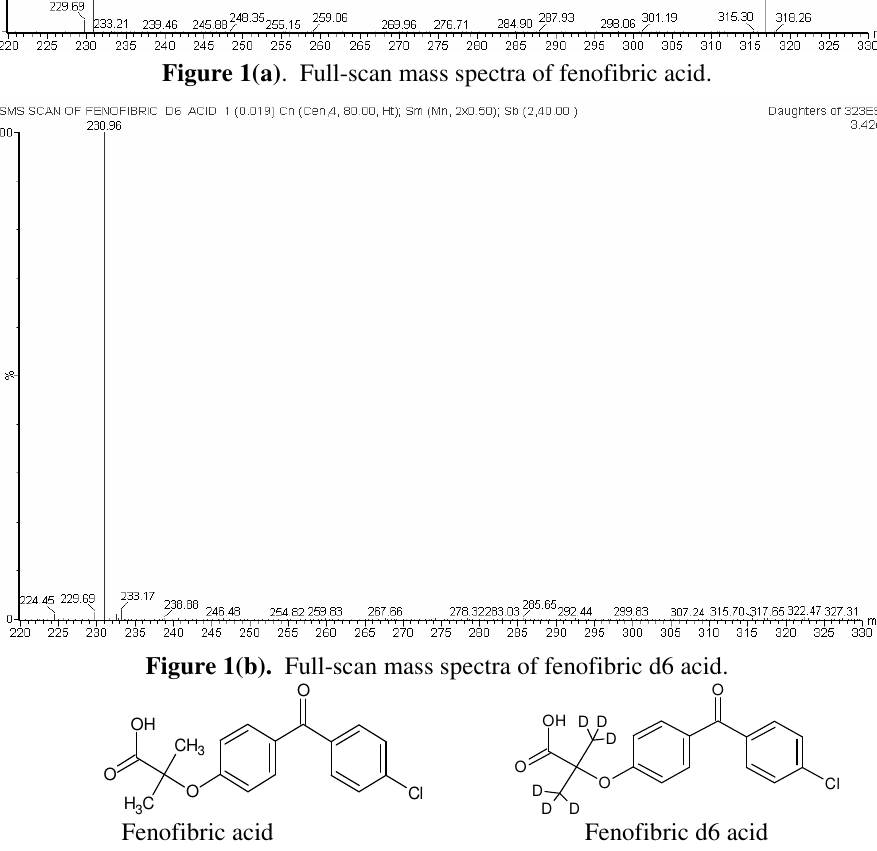
Figure 2 . Chemical structures of fenofibric acid and fenofibric d6